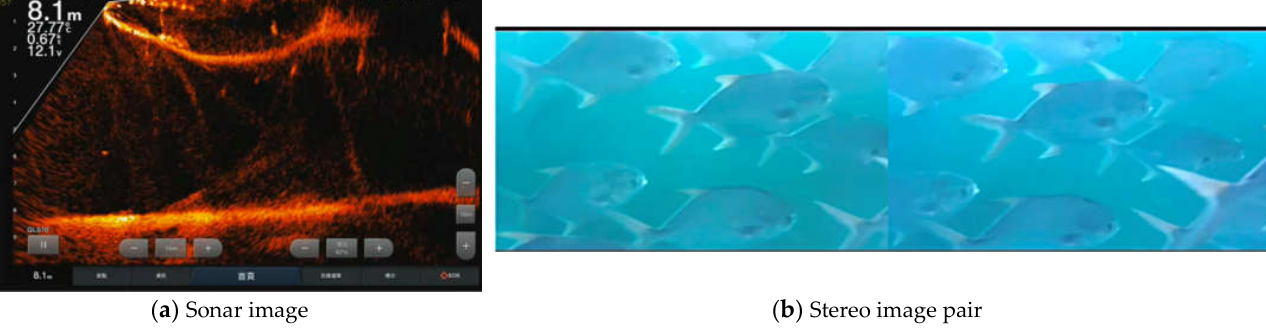
Figure 1. Data captured from the sensor devices is transmitted to the cloud for storage and big data analytics.